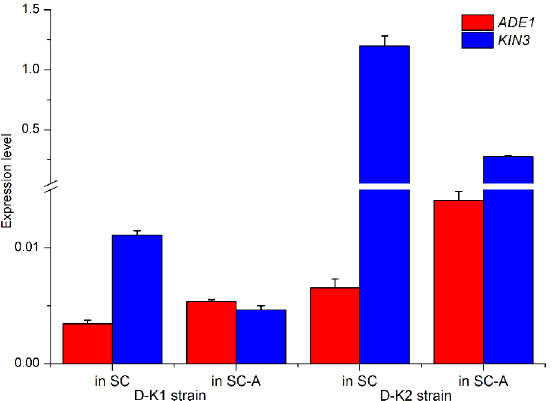
Figure 7. Phenotypic effect of anti-regulation between a convergent pair in a nutrient-limited environment. Growth phenotype of the wild type strain (YL1C WT ) and seven strains (D-K1 to D-K7; see Table 2 ) genetically modified for the convergent gene pair ADE1 and KIN3 . Strains were cultured in complete (SC) or adenine barren (SC-A) medium.